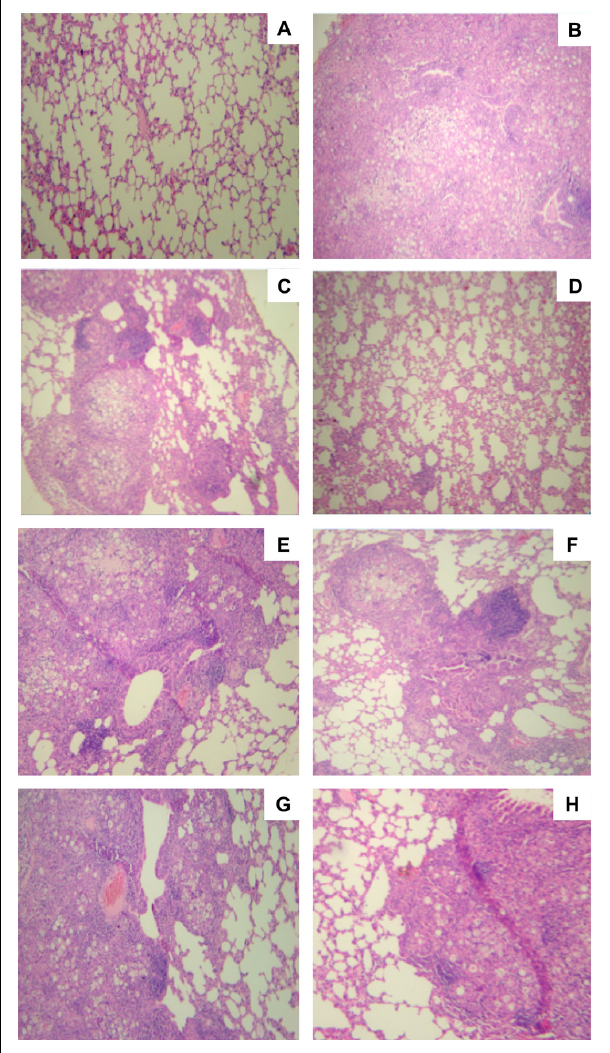
FIGURE 3 | Histological sections of murine lungs from i.t. infected BALB/c mice submitted to immunization with P10 associated to cationic lipid. Groups of mice included (A) uninfected controls, (B) unimmunized infected controls, (C) infected and immunized only with the cationic lipid, (D) infected and immunized with cationic lipid plus P10, (E) infected and immunized only with FliC flagellin, (F) infected and immunized with FliC flagellin plus P10, (G) infected and immunized only with aluminum hydroxide, (H) infected and immunized with aluminum hydroxide plus P10 after 52 days of infection. H&E staining, × 10 magnification.